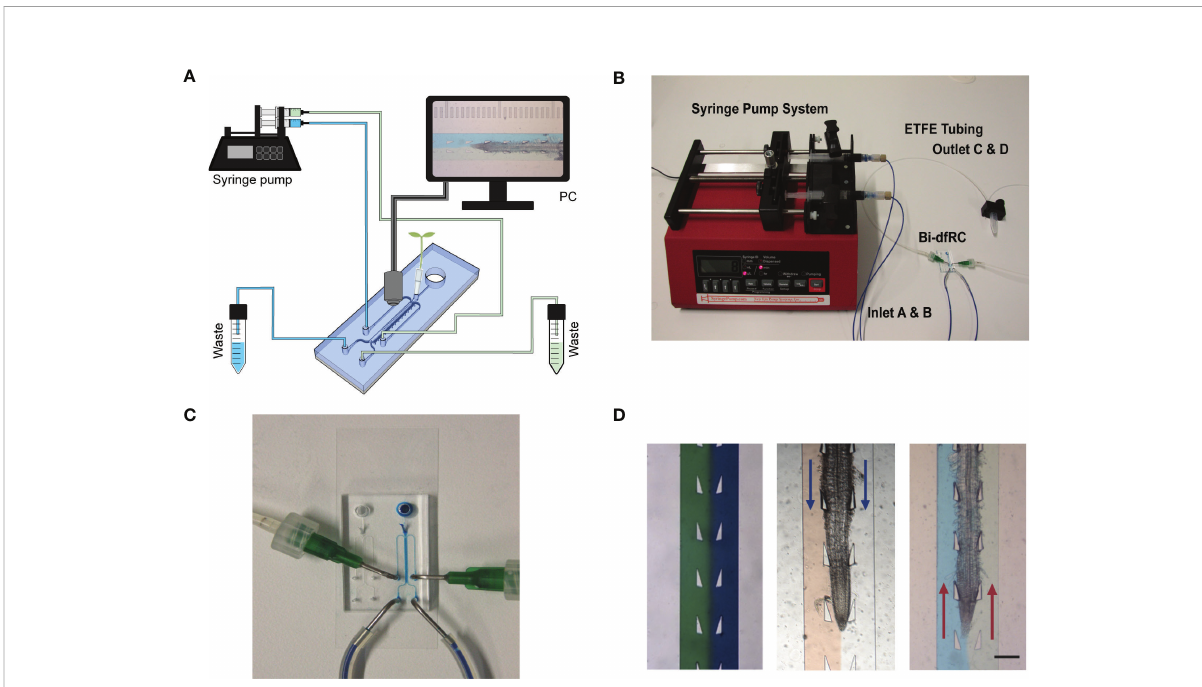
FIGURE 2 Bi-directional dual- fl ow-RootChip (Bi-dfRC) imaging set up. (A) Schematic diagram of the bi-dfRC set up with syringe pump system and tubing array for imaging. (B) Photograph of the syringe pump system, tubing and chip adapter used for the delivery of asymmetric test solutions into the bi-dfRC microchannels. (C) Close-up depicting the fl uid fl ow into the observation chamber delivered by tubing network into the bi-dfRC in the absence of a root using blue dye (scale bar 5 mm). (D) Arabidopsis 9-day old G-CaMP3 root under asymmetric fl uidic fl ow visualised using coloured dye in the absence and presence ( fl ow direction indicated with blue arrows for differentiation zone and red arrows for tip) of a root (scale bar 350 m